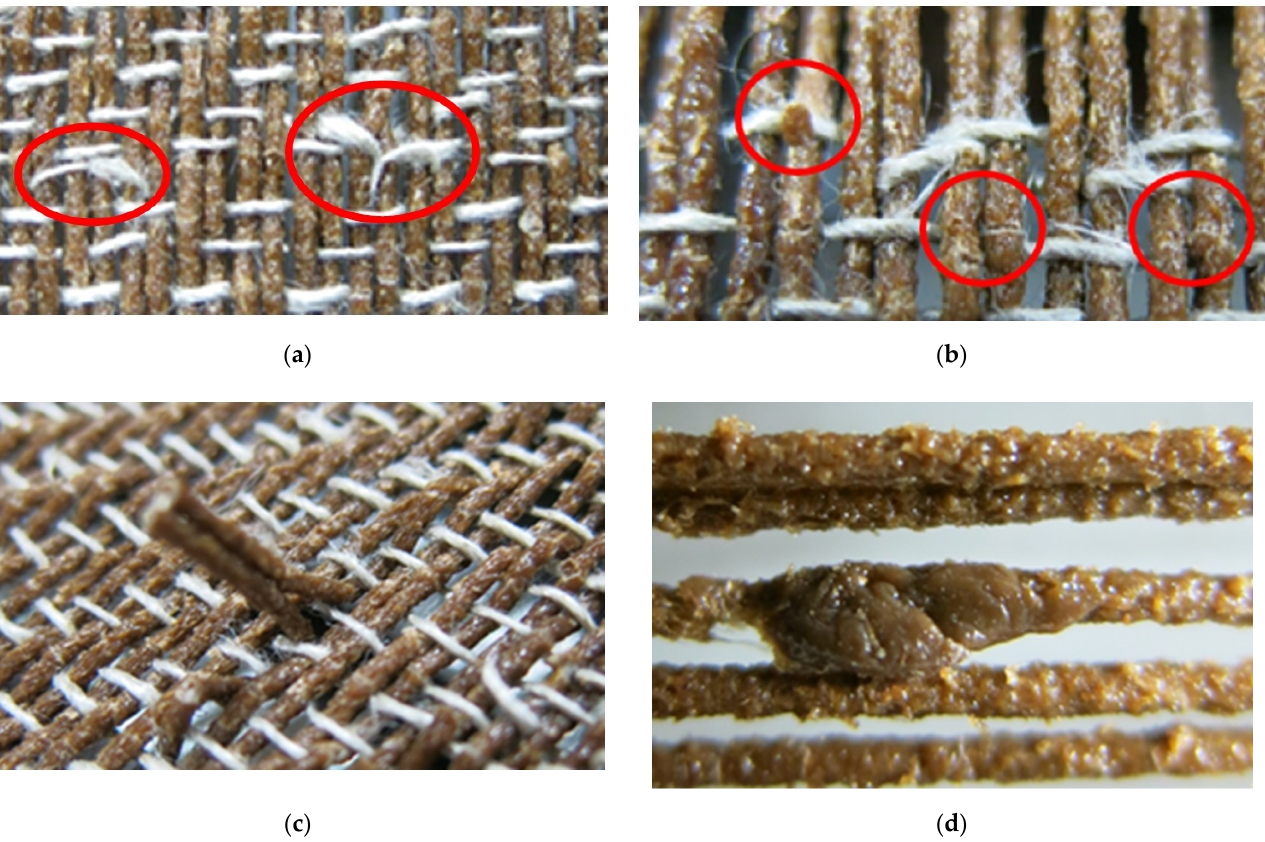
Figure 4. ( a ) Broken weft yarn; ( b ) broken lignin coating of the warp yarns; ( c ) broken Warp yarn; ( d ) in-homogeneous lignin coating of the warp yarn. ( d ) in-homogeneous lignin coating of the warp